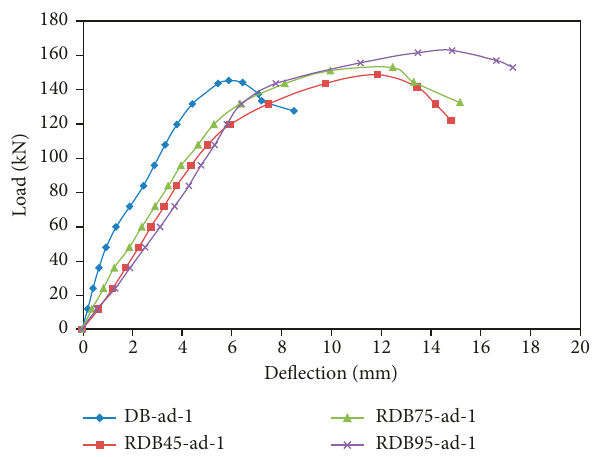
Figure 7: Load-deflection plot of shear-deficient beams tested at a / d ratio 3.